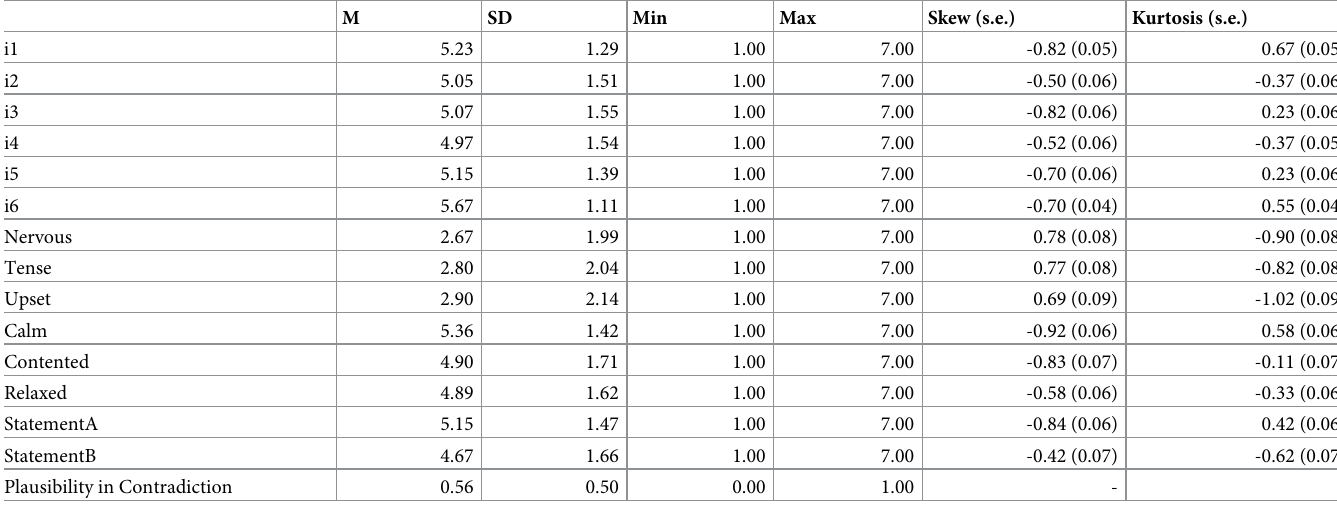
Table 3. Descriptive statistics of the variables from Study